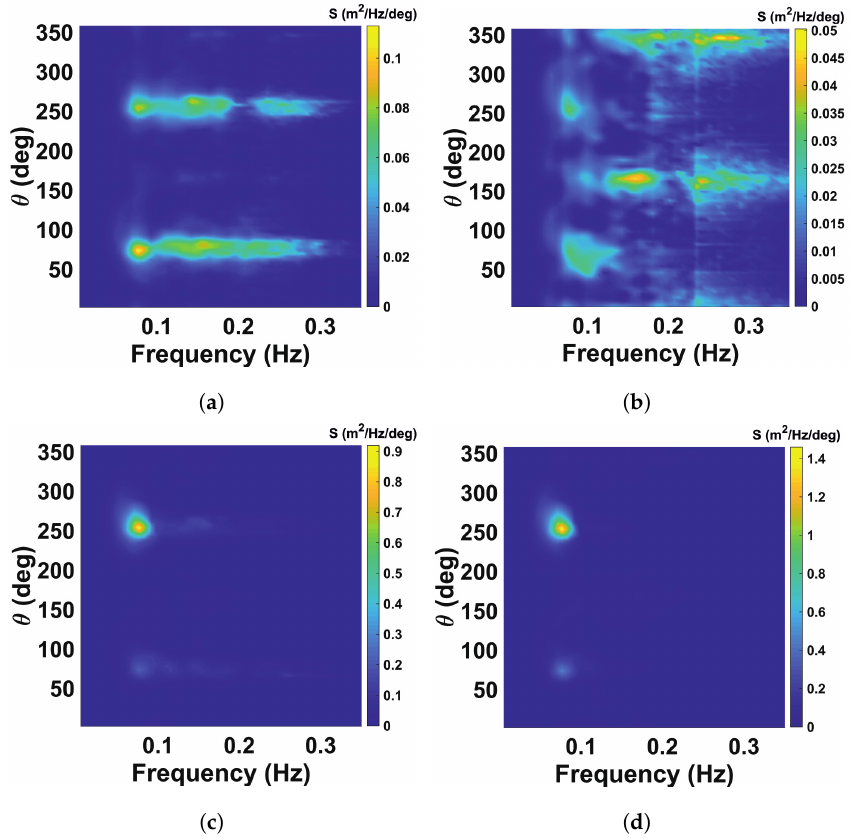
Figure 8. WaMoSII frequency spectra for insufficient sea clutter (upper row) marked as unreliable data and insufficient sea clutter marked as reliable signal (bottom row). The left column shows the standard results including artefact of the interferences. In right column the corresponding spectra after interference removal are shown. Streaks spectrum is well-pronounced in its theoretical location. ( a ) insufficient sea clutter (II) with artefacts before filtering. ( b ) insufficient sea clutter after streaks filtration. ( c ) insufficient sea clutter marked as reliable data (IR) with artefacts before filtering. ( d ) insufficient sea clutter marked as reliable data (IR) after streaks